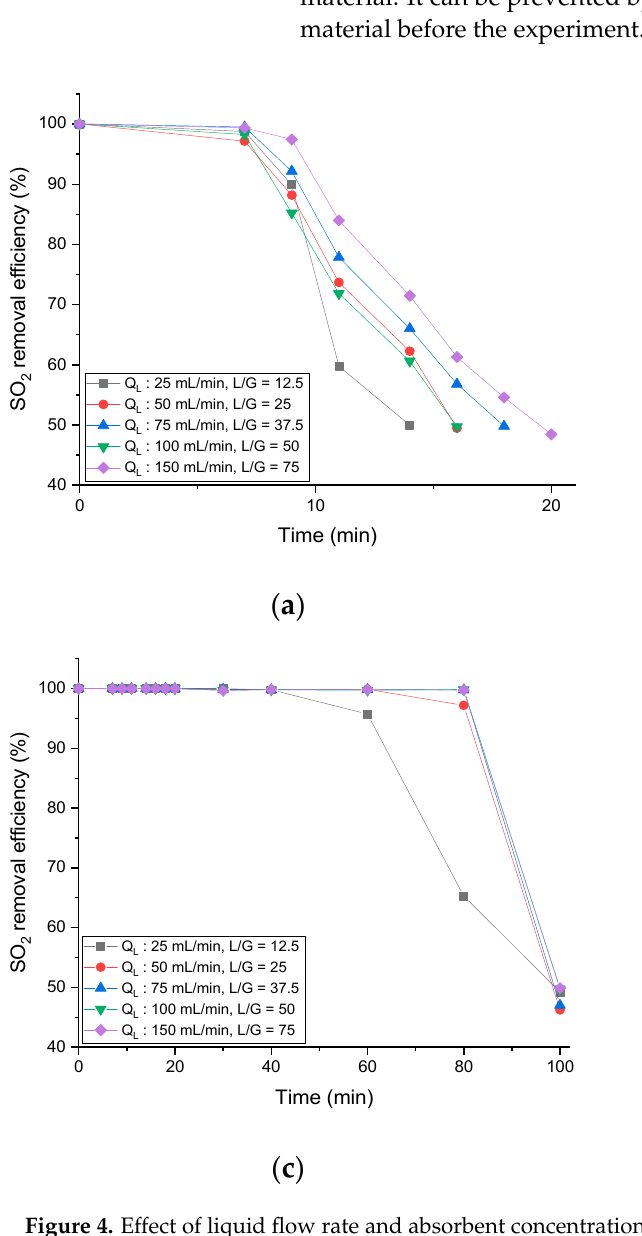
Figure 4. Effect of liquid flow rate and absorbent concentration on SO 2 removal efficiency: ( a ) 0.005 M NH 4 OH; ( b ) 0.01 M NH 4 OH; ( c ) 0.05 M NH 4 OH; ( d ) 0.1 M NH 4 OH.